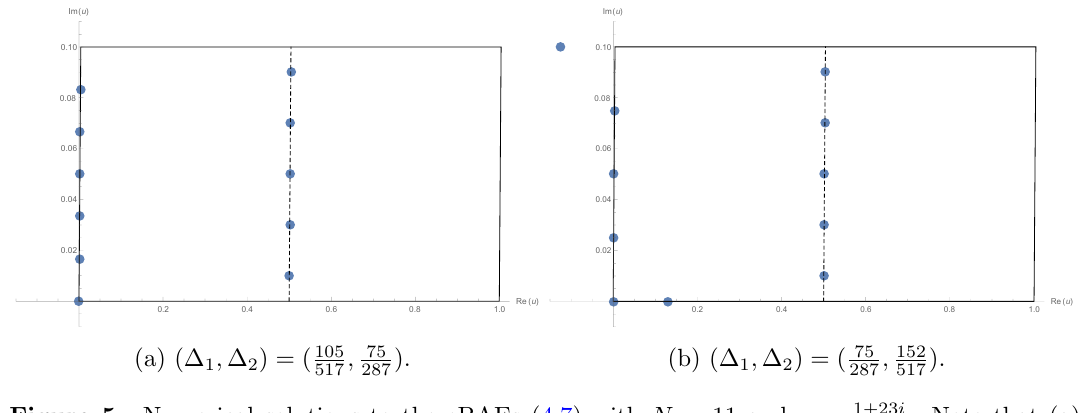
. Note that (a) 230 ). 2